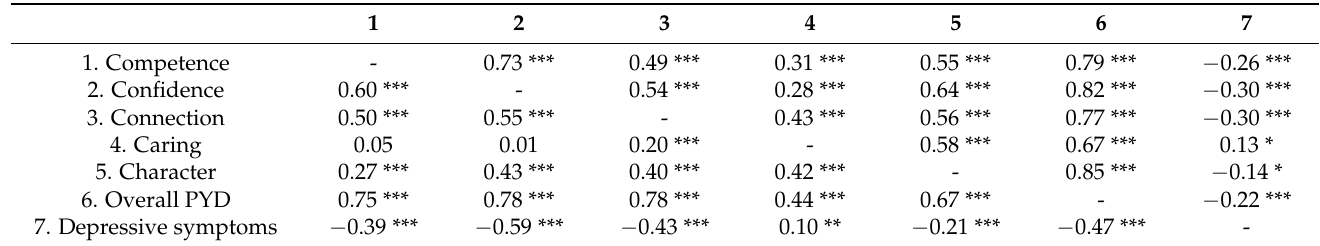
Table 4. Bivariate correlations between the 5Cs of PYD and depressive symptoms by country.